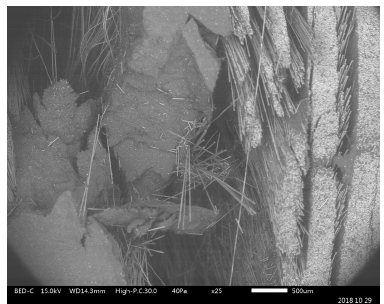
Figure 14. SEM micrographs of the composite of bonded adhesive at 864 h.